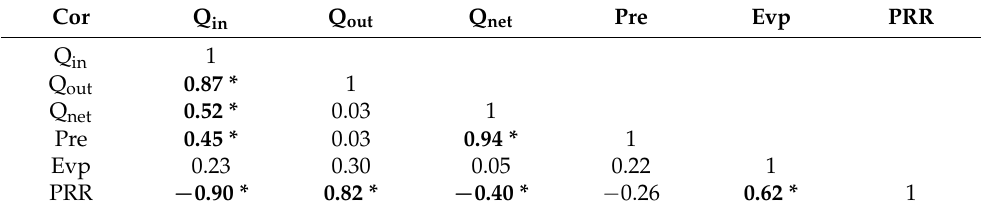
Table 2. The correlation coefficient between atmospheric water cycle factors. Cor Q